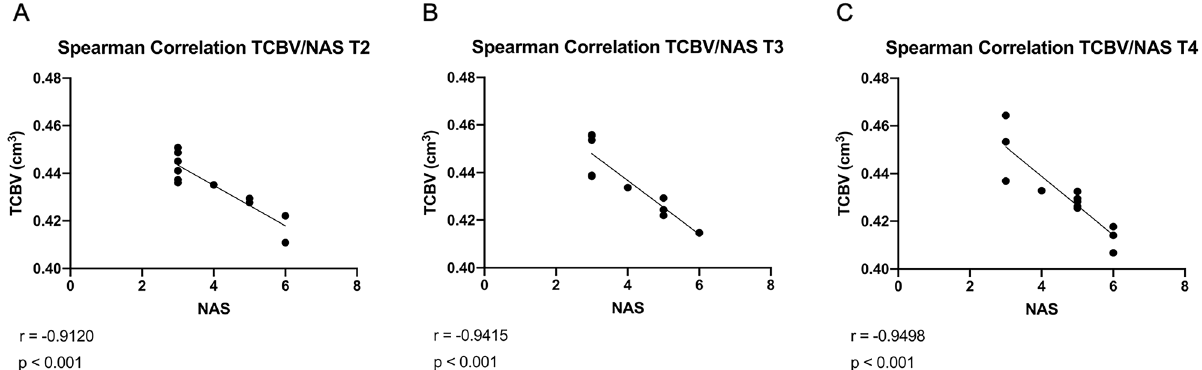
Figure 3. Relationship between TCBV (Total cerebral brain volume, cm 3 ) and NAS (NAFLD Activity Score, 0–8) by Spearman-related analysis. Lines are generated using regression analysis (GraphPad Prism); r = Spearman’s correlation coefficient; NAS represents the sum of scores for steatosis, lobular inflammation, and ballooning; (A) T2: 8 weeks; (B) T3: 20 weeks; (C) T4: 28 weeks.